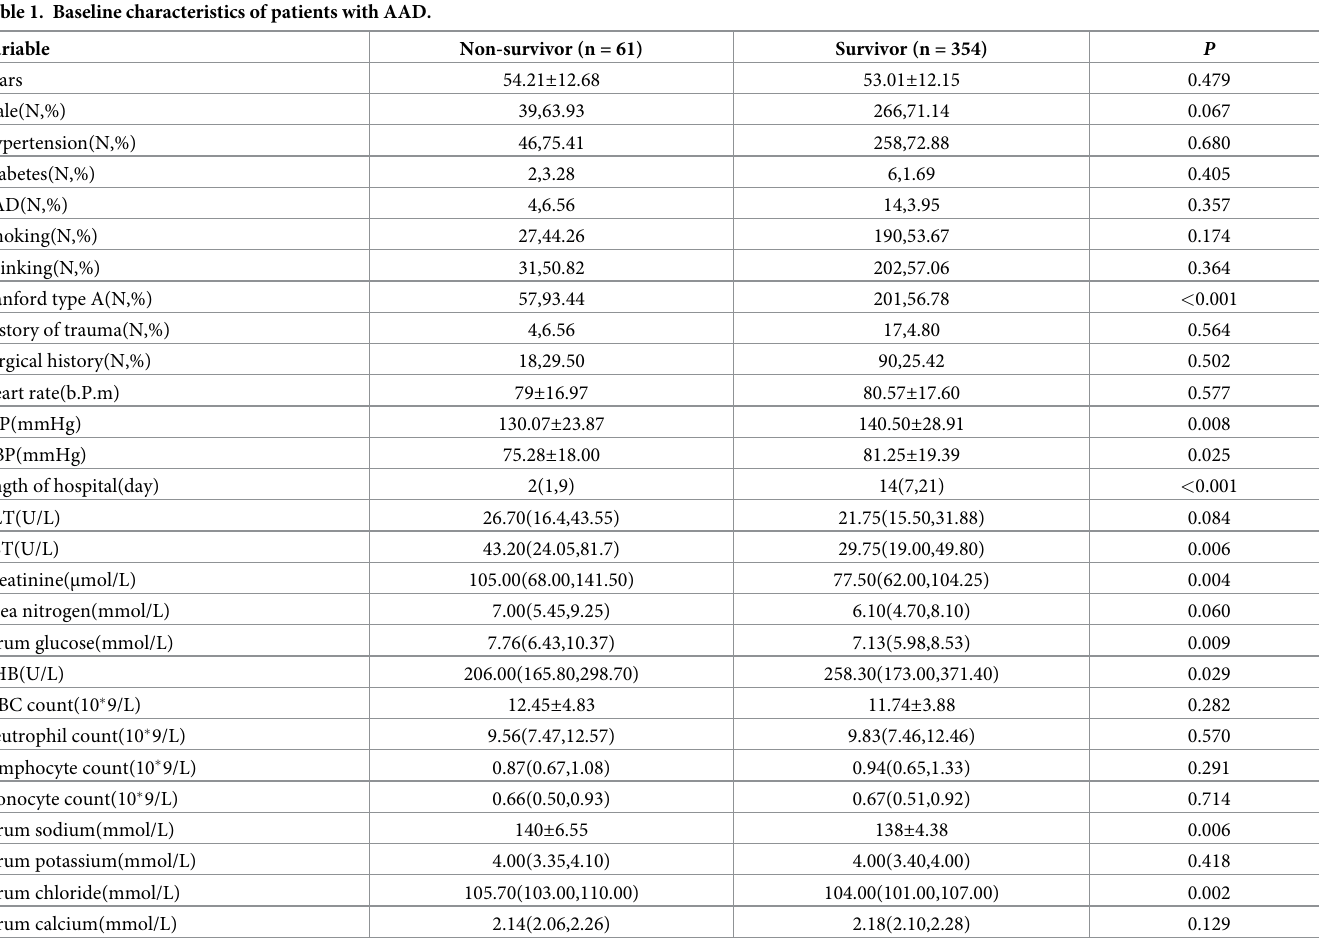
Table 1. Baseline characteristics of patients with